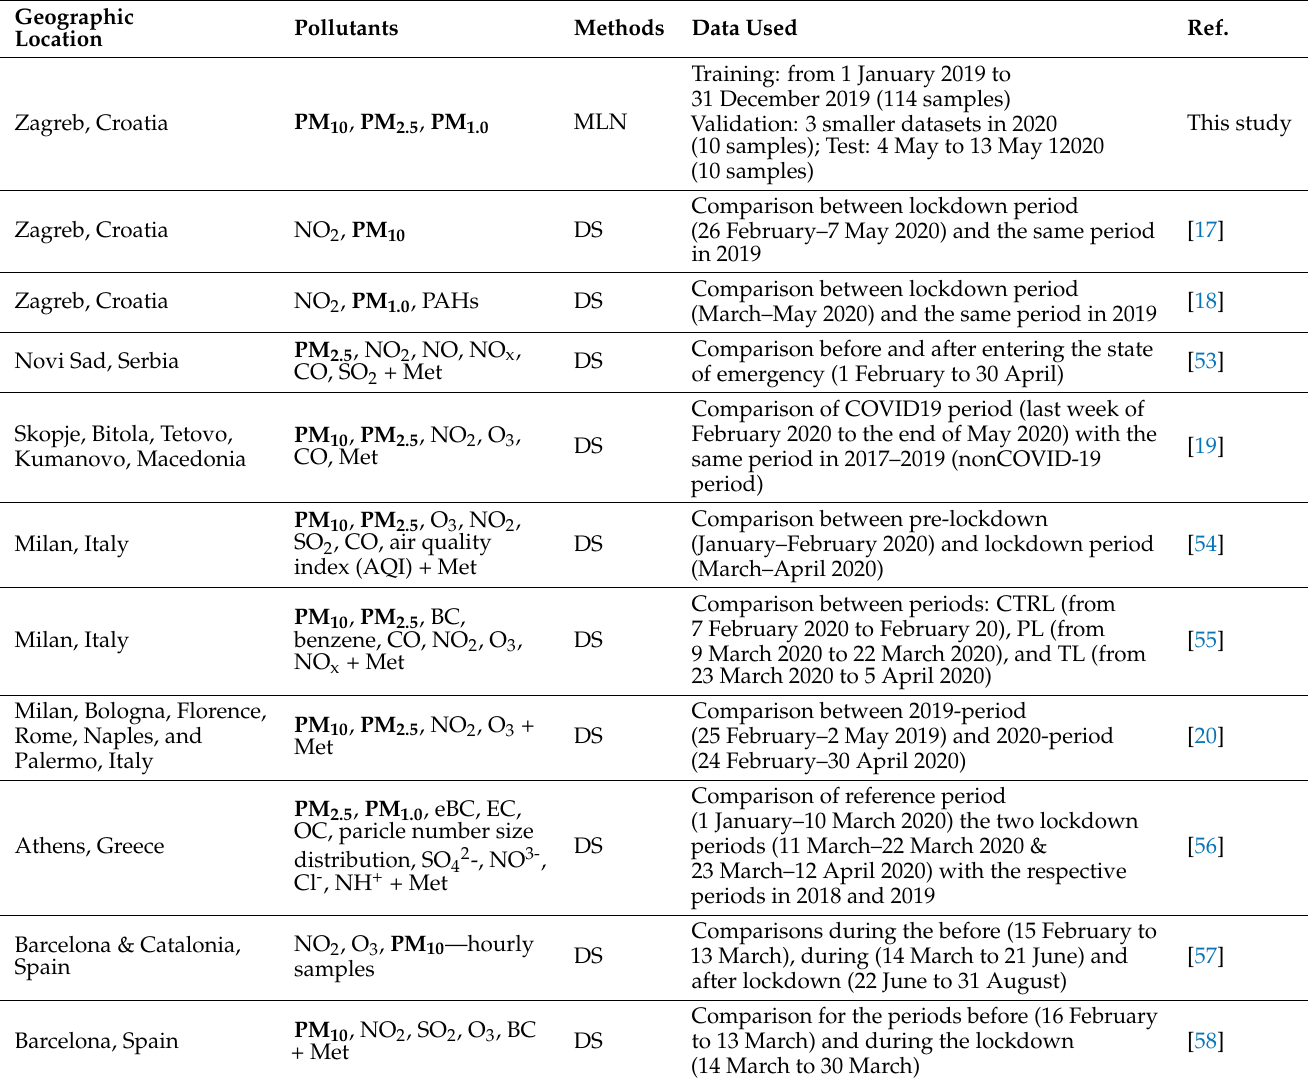
Table 2. Literature findings on the lockdown’s effects on particulate matter concentration. Abbre- viations used: Machine learning (ML), Descriptive statistics (DS), Modelling (MD), Unsupervised methods (UM), Meteorology (Met), Machine learning with normalization (MLN). Methods Data Used